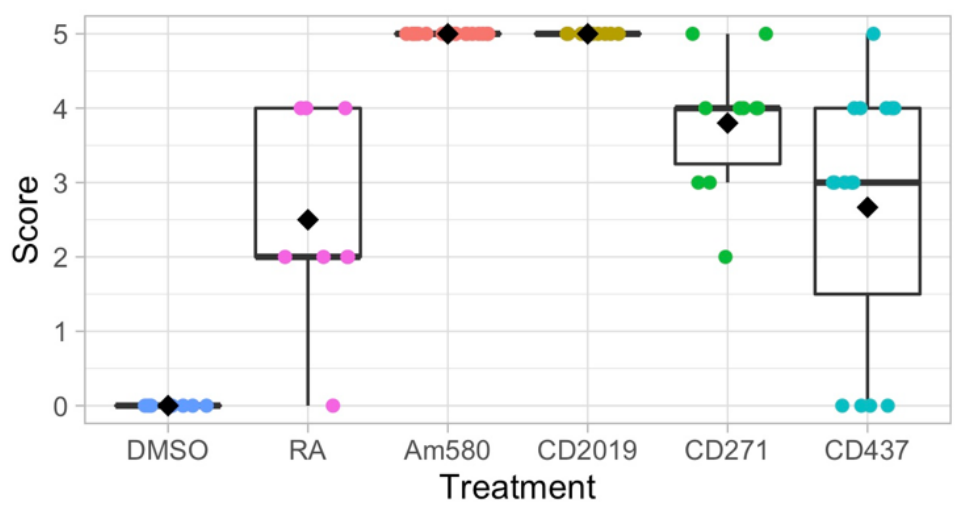
Figure 3. Duplication of forelimb regenerates from juvenile axolotls (3 – 5 cm) treated systemically with 250 nM Am580 ( n = 20 limbs), CD2019 ( n = 10), CD271 ( n = 10), or CD437 ( n = 15). Retinoic acid